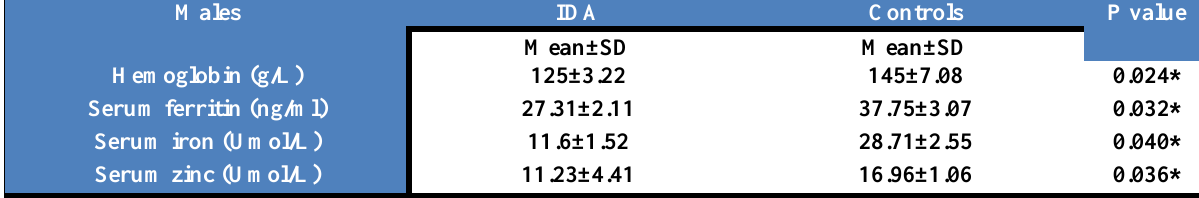
Table, 1: Some parameters for iron deficiency anemia without parasitic worms and control groups in males. Males